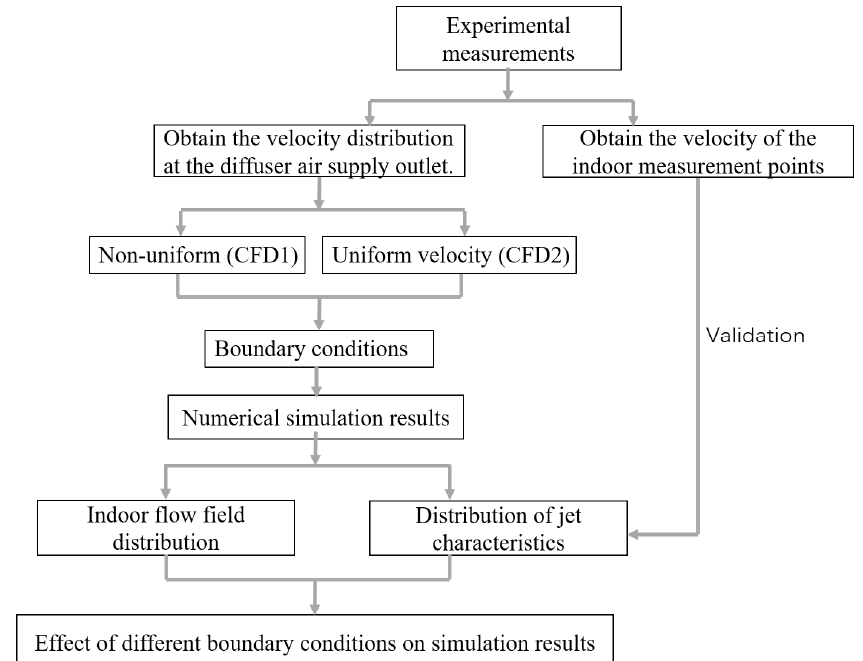
Figure 1. Technical route of study.